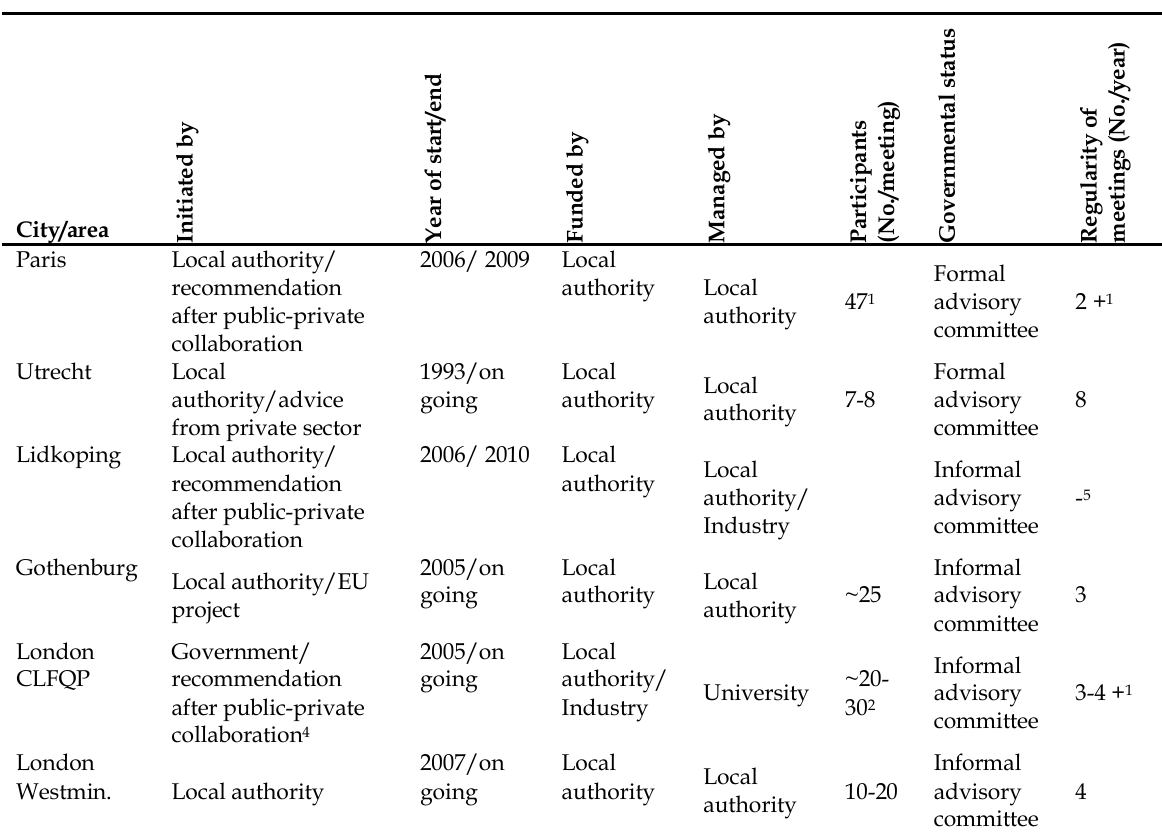
Table 2. The characteristics of different urban freight transport partnerships